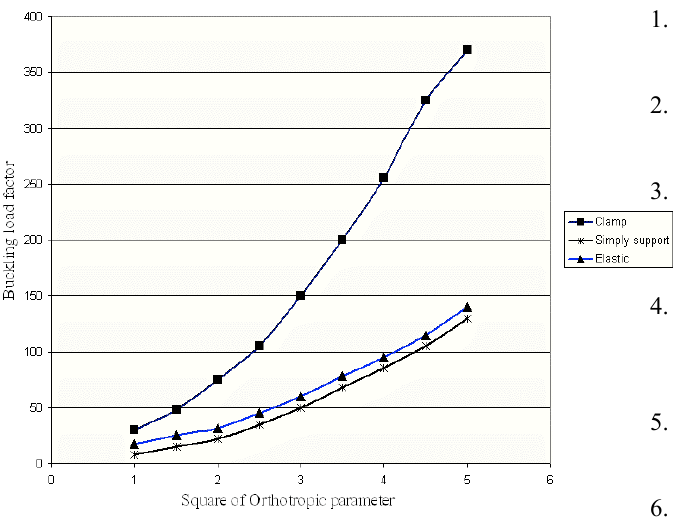
Fig. 4. Variation of buckling load factor respect to orthotro- pic parameter for different boundary conditions